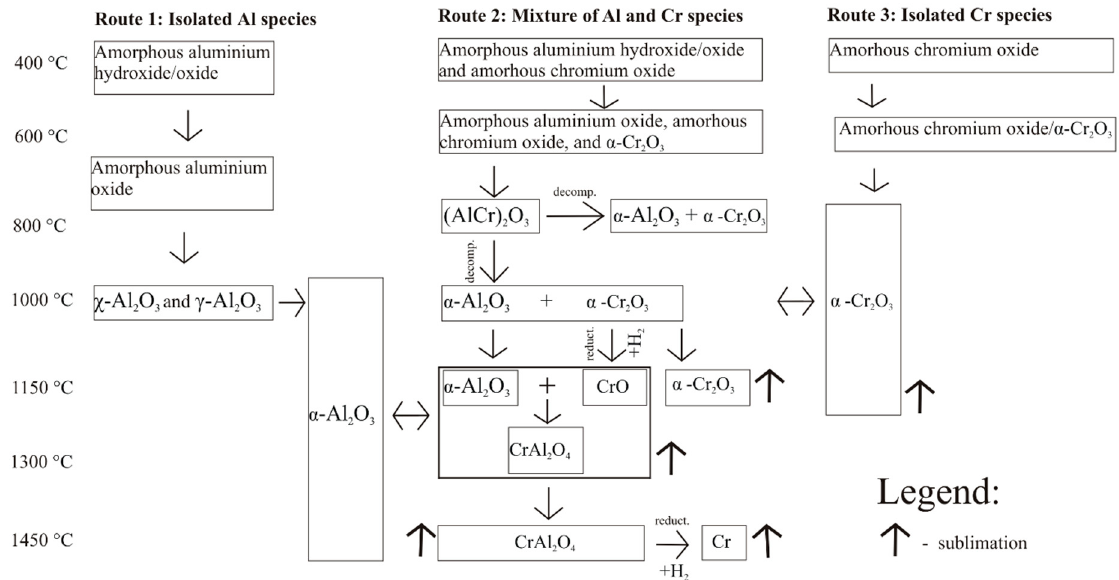
Figure 3. Phase transformation of co-precipitated Al and Cr oxides as a function of temperature. At 1150 ◦ C, the XRD measurements revealed the presence of diffraction peaks at 2 θ ca. 18.68 ◦ , 30.79 ◦ , 36.29 ◦ , 44.35 ◦ , and 64.68 ◦ . A good matching of these peaks to the MgAl 2 O